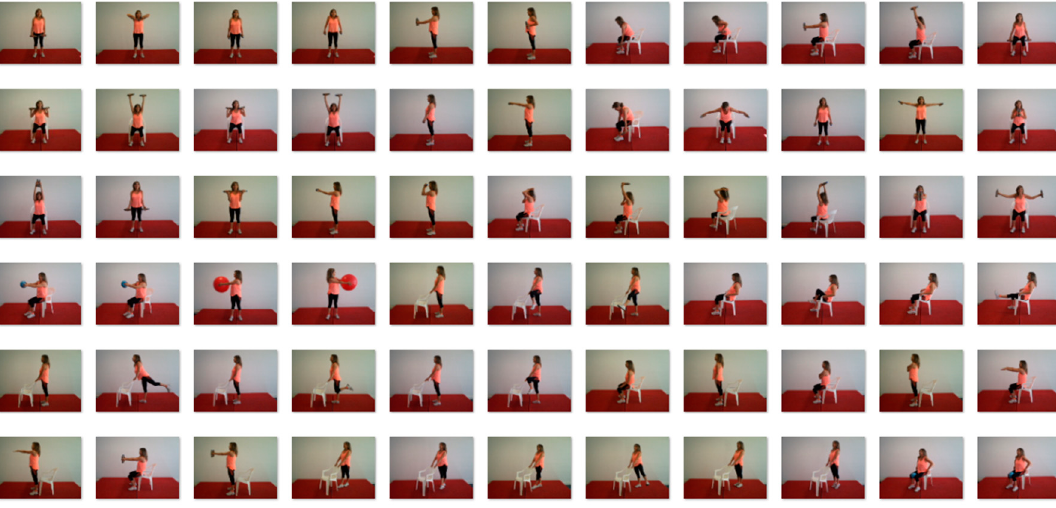
Figure 1. Resistance exercises used in the exercise program.